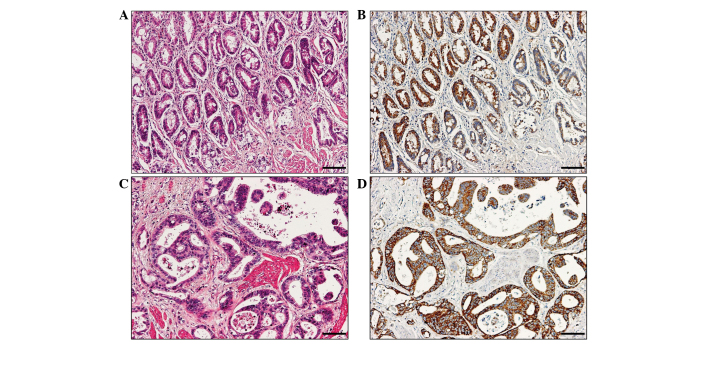
Immunohistochemical staining of BMP8B in human gastric cancer. (A) Hematoxylin-eosin (HE) staining of the gastric mucosa. (B) High BMP8B protein expression in gastric cancer cells infiltrating the gastric mucosa. (C) HE staining of the muscularis propria. (D) High BMP8B protein expression in gastric cancer cells infiltrating the muscularis propria. Scale bars, 100 μm. BMP8B, bone morphogenetic protein 8B.